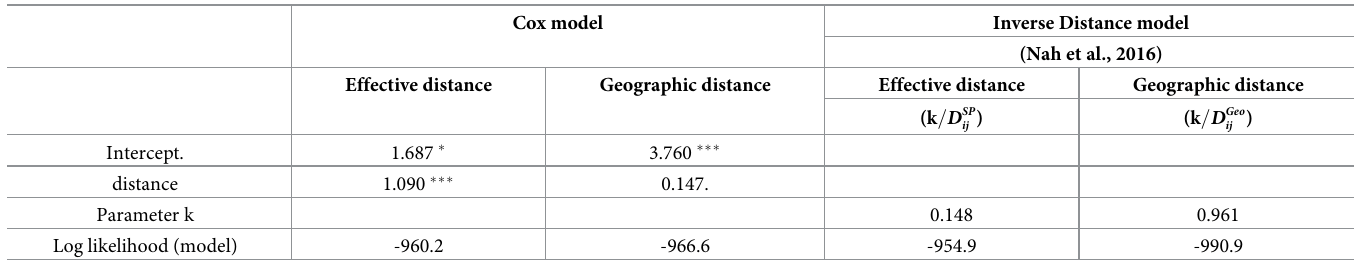
Table 5. Survival model results with the shortest path of effective distance.